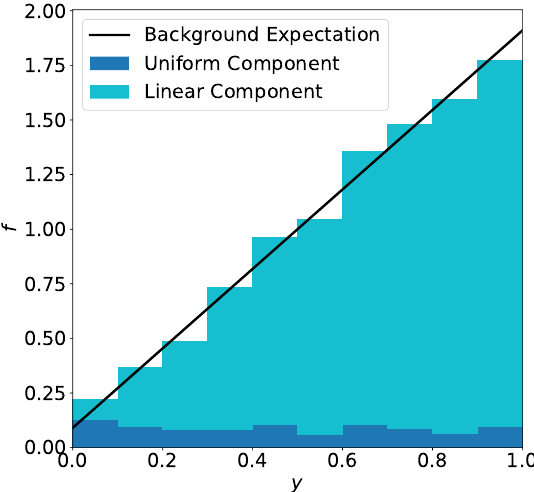
Figure 31 . The background distribution (A.1) for the example with linearly increasing background considered in section A.1, for N U /N L = 0 . 1